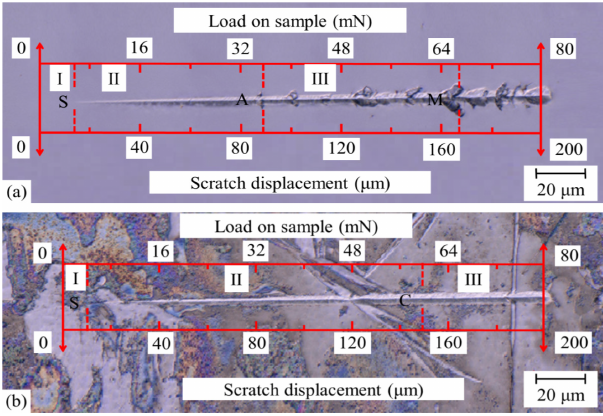
Figure 6. The scratching microscopic morphology of (a) Si and (b) Si (UV-2 # )